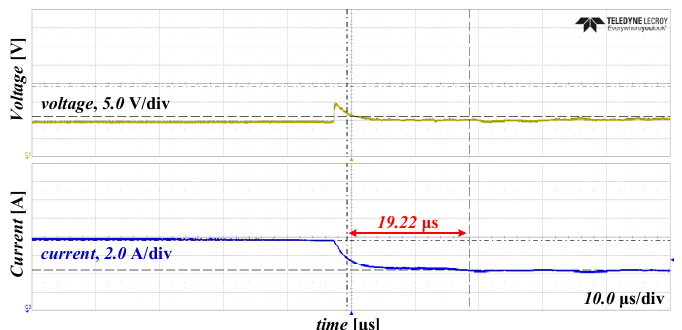
Figure 20. Experiment result for dynamic response: Step C → B (Case 3).